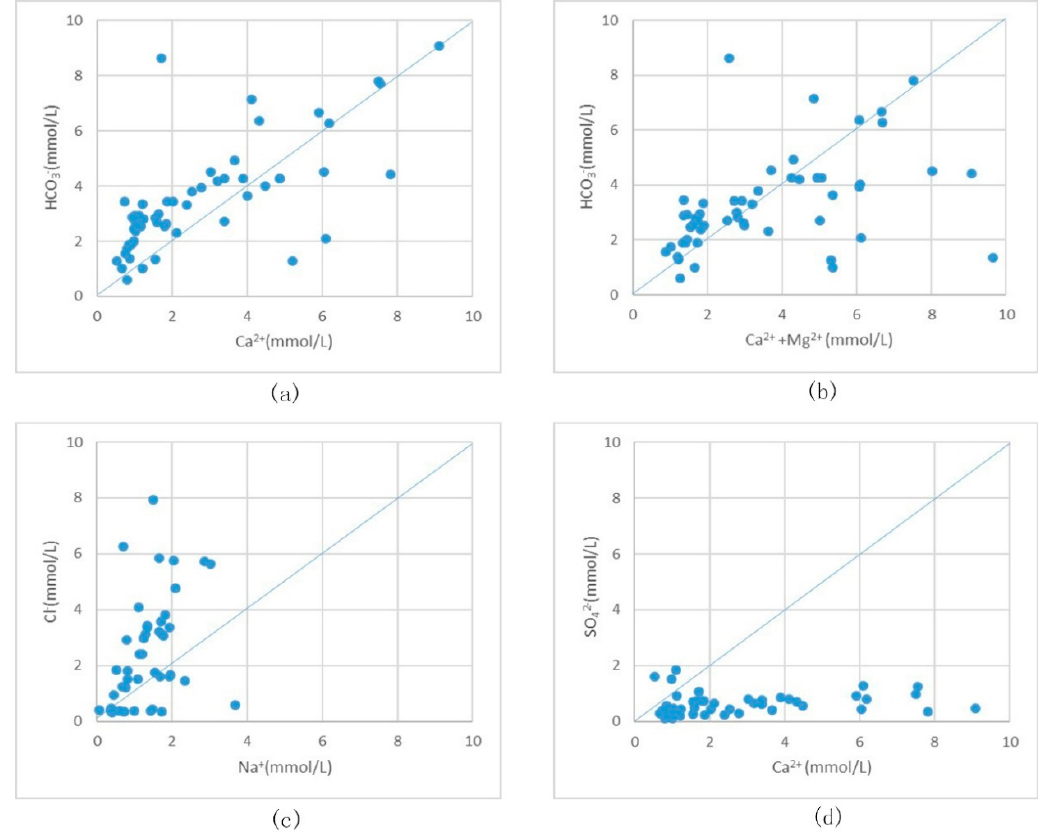
Figure 4. Ion ratio plots. ( a ) The scatter plot of Ca 2 + and HCO 3 − can be used to analyze the dissolution